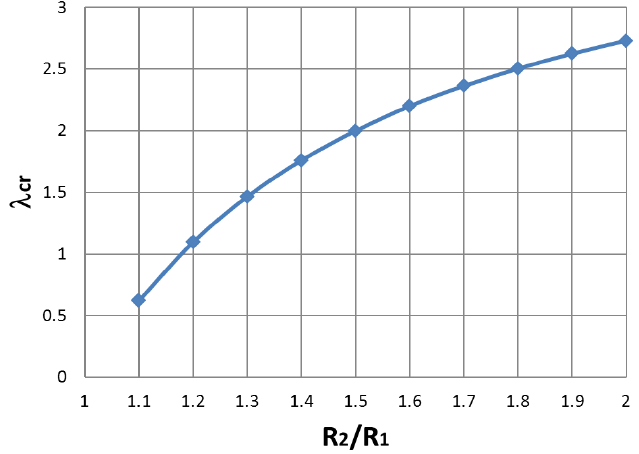
Figure 1:  cr vs. R 2 /R 1 , for  = 1,  = 3/4,  = 0.25, H/R 1